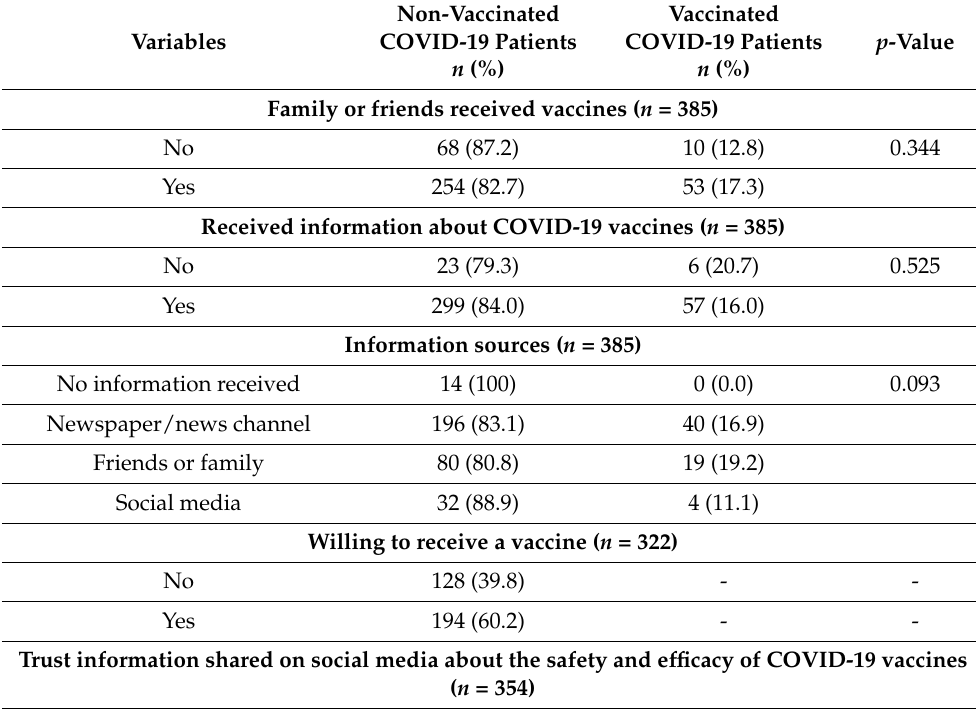
Table 2. COVID-19 vaccination-related factors by vaccination